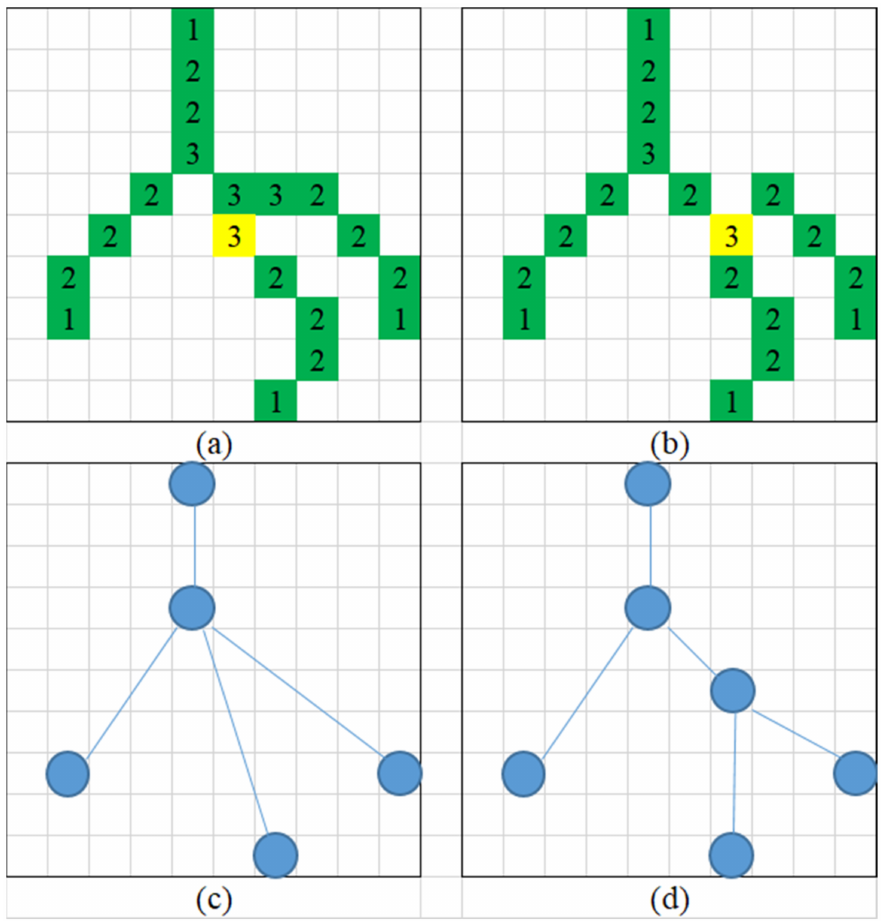
Figure 14. An example of the algebraic difference in airways. Here, ( a ) is the skeletonization example of the assumed algorithm A, ( b ) is the skeletonization example of the assumed algorithm B, ( c ) is the tree diagram converted from ( a ), and ( d ) is the tree diagram converted from ( b